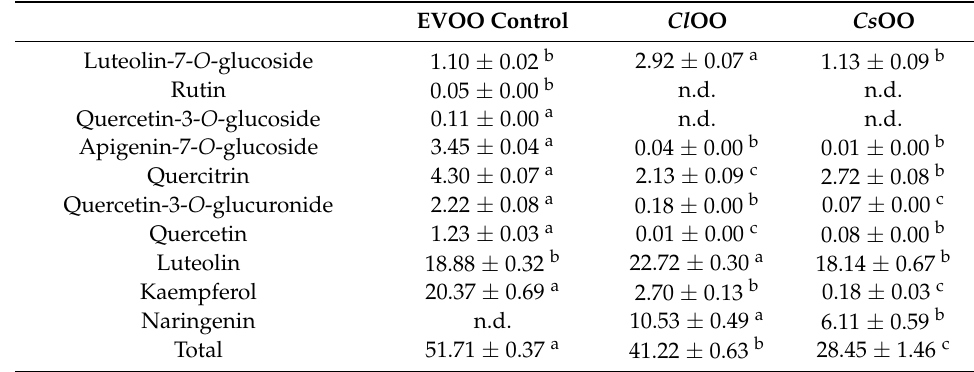
Table 6. Changes in the composition of flavonoids ( µ g/mg phenols) in lemon olive oil ( Citrus limon olive oil Cl OO), orange olive oil ( Citrus sinensis olive oil Cs OO) and Control extra-virgin olive oil (Control